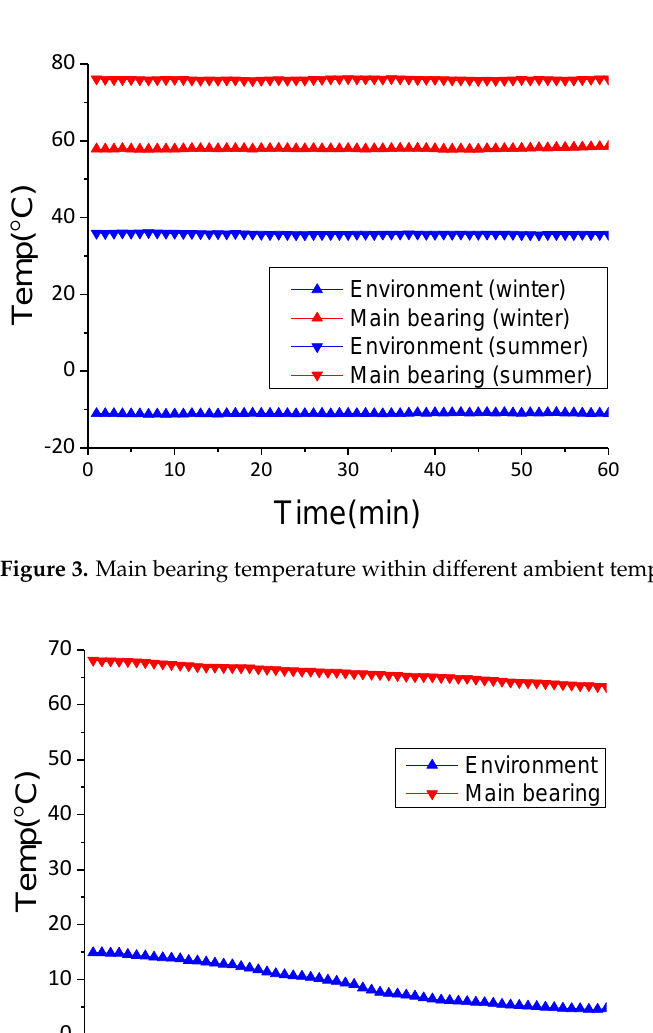
Figure 3. Main bearing temperature within different ambient temperatures.